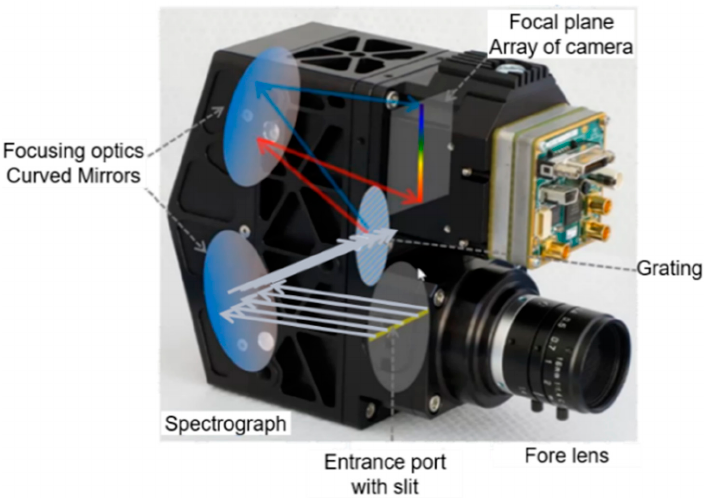
Figure 4. The optic system inside the Nano-Hyperspectral sensor based on offner spectrometer: the light passing through the slit is projected in the focal plane (camera array of CCD) with almost no distortions. Next, the light is separated according to the wavelength creating a hyper pixel. Adapted from Headwall Photonics, Inc.